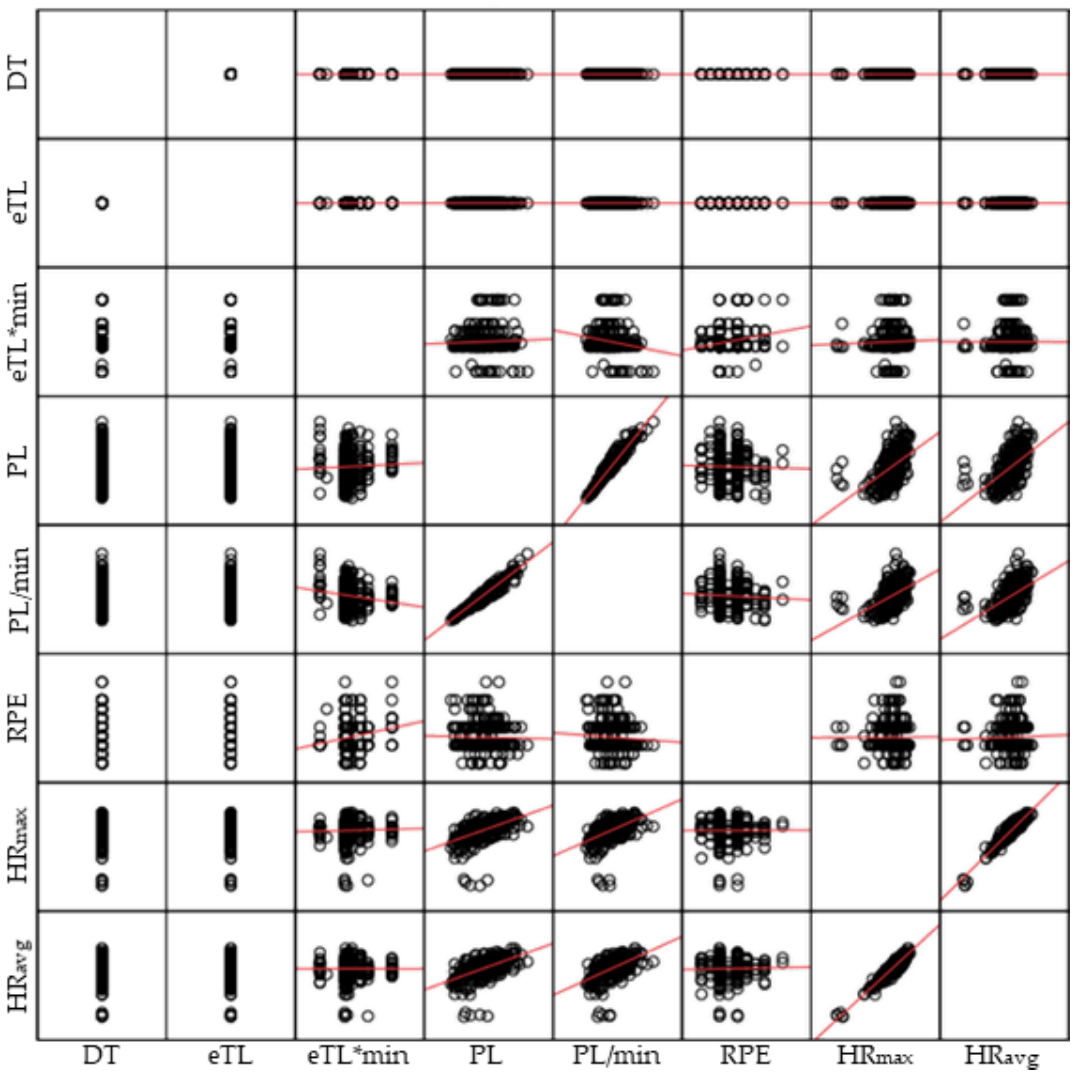
Figure 4. Matrix scatter plots between the intensities studied (in pairs) in the 3 vs. 3 matches. Note: eTL = External Intensity; TD = Task Density; PL = Player Load; min = Minute; iTL = Internal Intensity; HR = Heart Rate; avg = Average; max = Maximum.